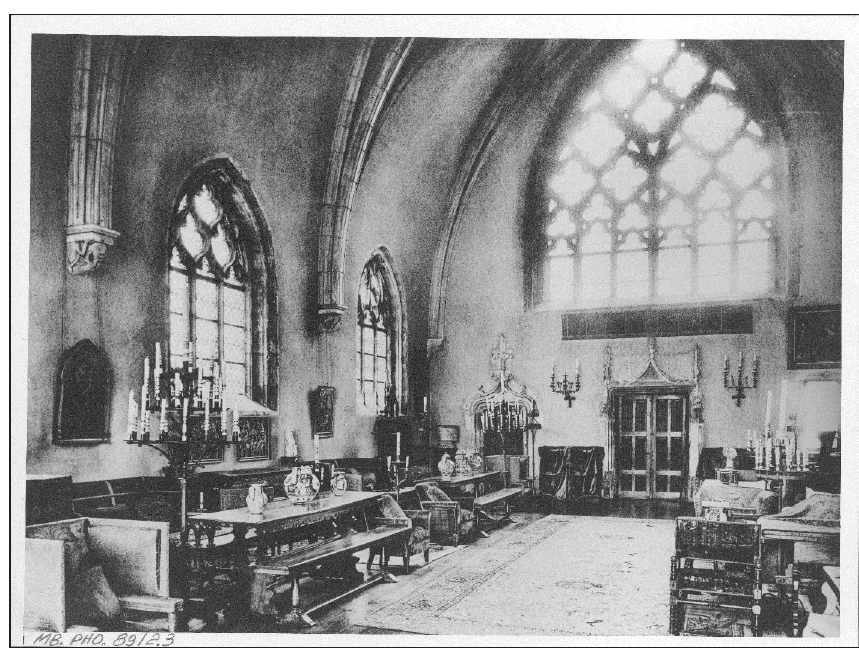
Fig. 3 : Interior view of the Blumenthal’s Gothic room, 15 boulevard de